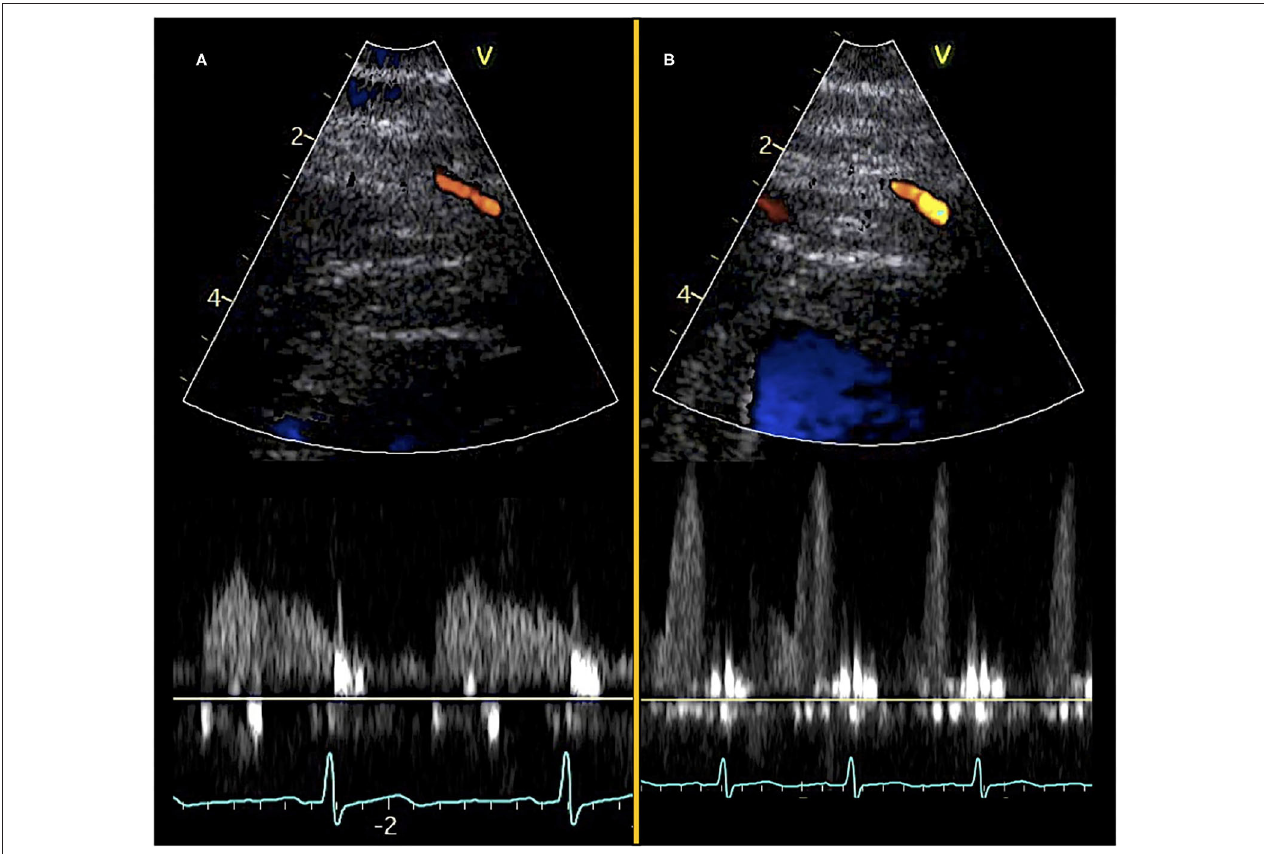
FIGURE 1 | Transthoracic Doppler echocardiography and pulsed-wave Doppler curves. Color Doppler visualization of mid-distal LAD (top) and diastolic pulsed-wave flow velocity curves (bottom). (A) Images obtained at rest and (B) images obtained during adenosine